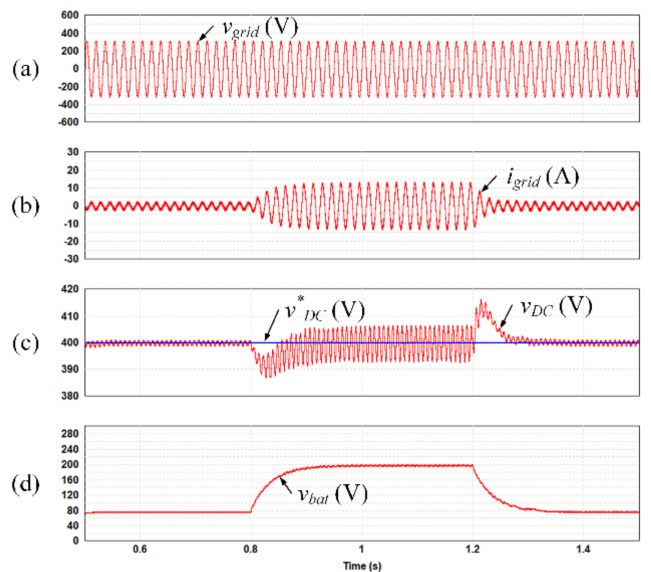
Figure 11. Simulation results of integrated OBC without proposed feed-forward control method in case the power of the battery-side is abruptly changed: ( a ) voltage and ( b ) current of the single-phase grid source, ( c ) DC-link voltage and reference DC-link voltage, and ( d ) voltage of the